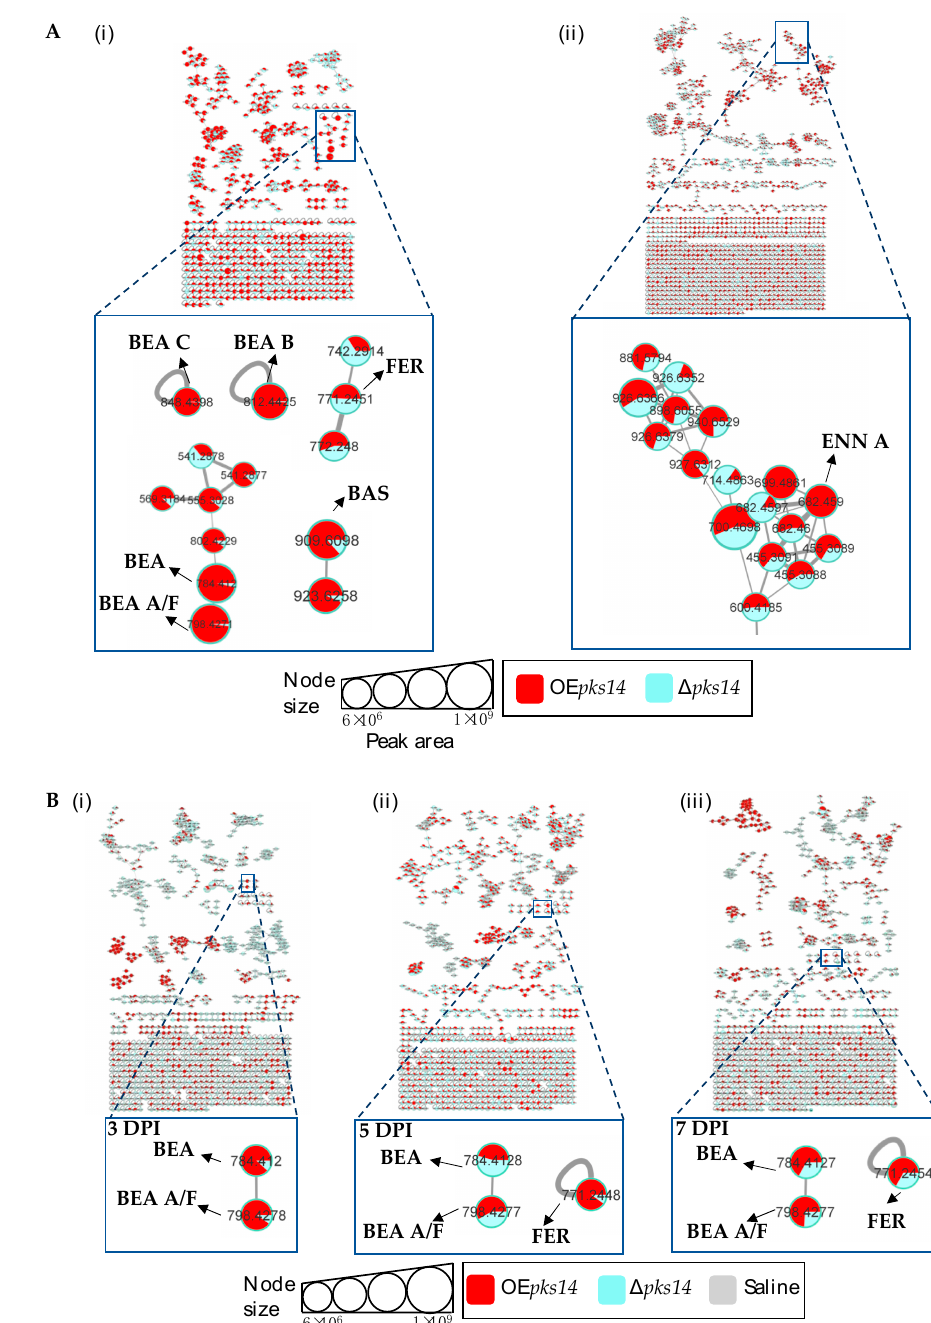
Figure 4. ( A ) Molecular networking of classified metabolites from OE pks14 (red) and ∆ pks14 (light blue) strains in culture identified beauvericin (BEA), beauvericin A/F (BEA A/F), beauvericin B (BEA B), beauvericin C (BEA C), bassianolide (BAS), and ferricrocin (FER) in cells (i) and enniatin A (ENN A) in culture broth (ii). ( B ) Molecular networking of classified compounds from OE pks14 (red) and Δ pks14 (light blue) strains in vivo at early-stage infection (3 DPI) for live larvae (i), mid-stage infection (5 DPI) for dead larvae (ii), and late-stage infection (7 DPI) for cadavers covered with fungal hyphae (iii) identified beauvericin (BEA), beauvericin A/F (BEA A/F), and ferricrocin (FER). Saline-injected BAWs were used as controls (gray). Node sizes represent the sums of chromatographic peak areas, and pie charts indicate chromatographic peak-area proportions for the detected insect virulence factors.